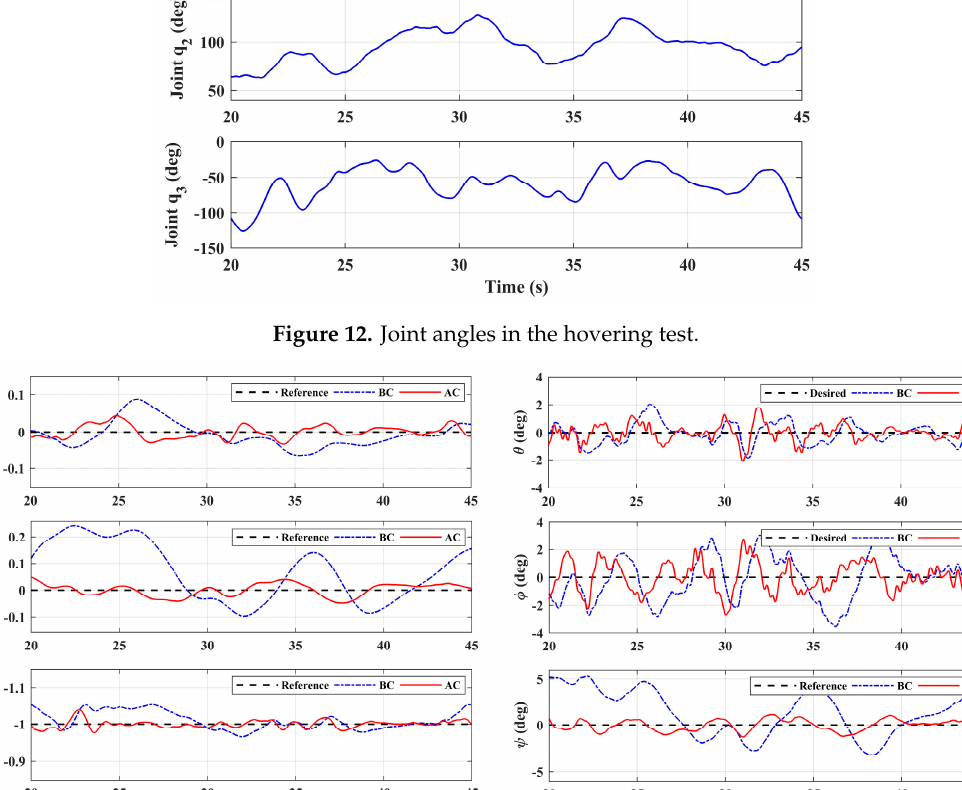
Figure 13. System responses in Scenario 1. Table 3. Root mean square error (RMSE) of Scenario 1.